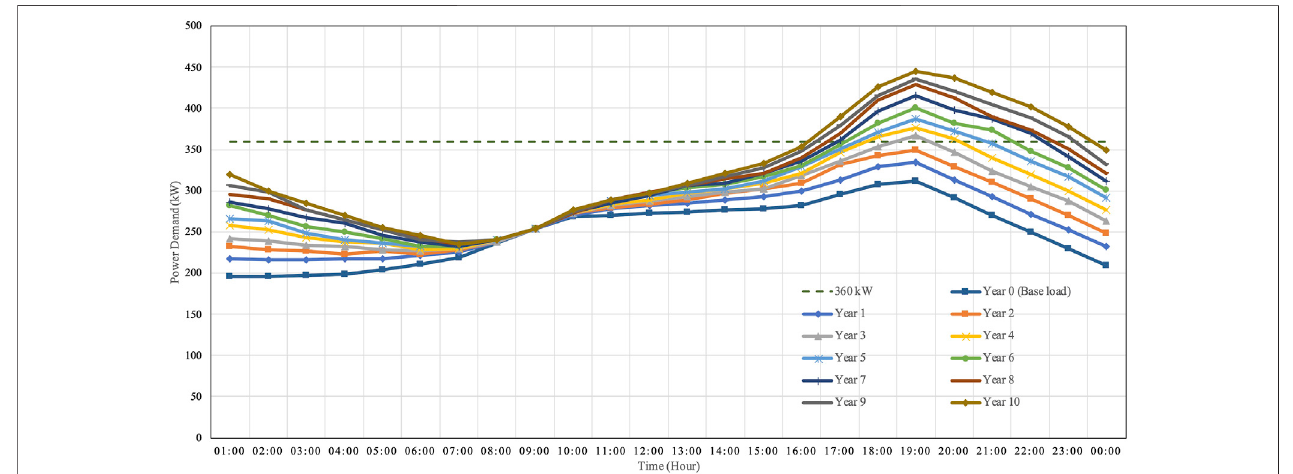
FIGURE 6 | Power demand as a function of time for uncontrollable charging over 10 years.